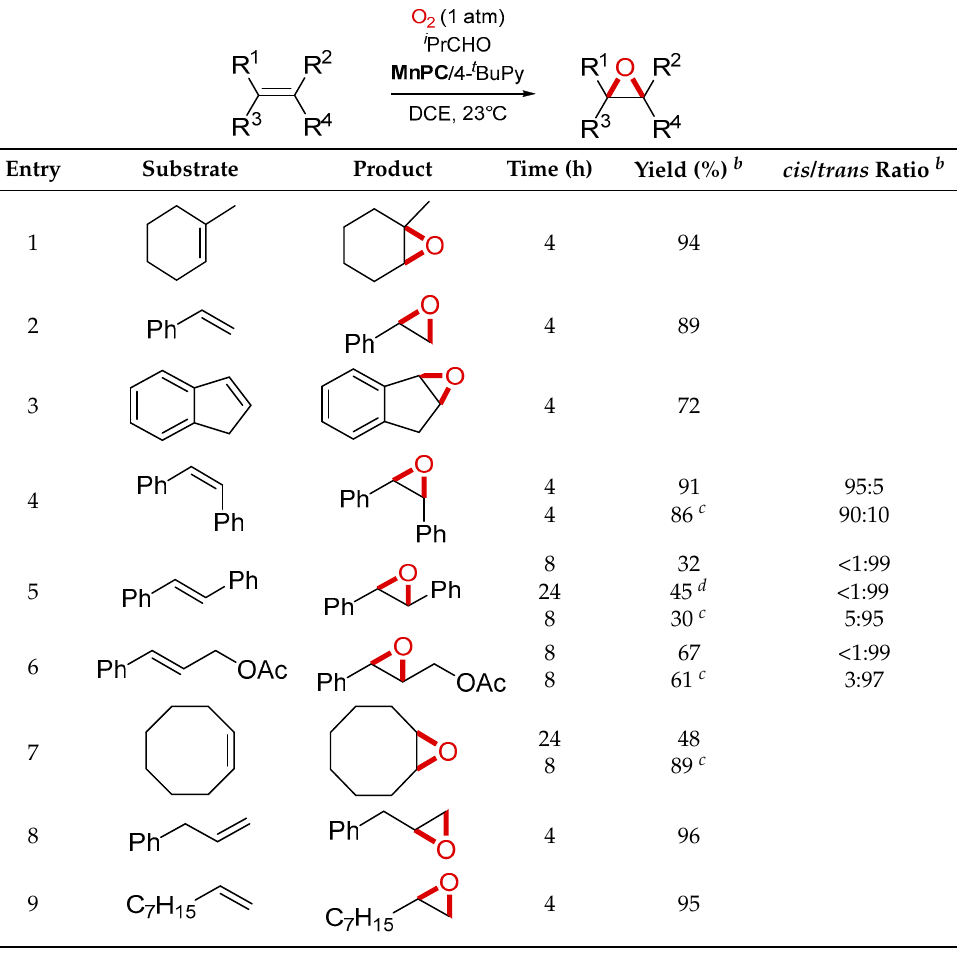
a Reaction conditions: olefin (0.2 mmol), isobutyraldehyde (2.0 mmol), 4- tert -butyl-pyridine (1.0 mmol),